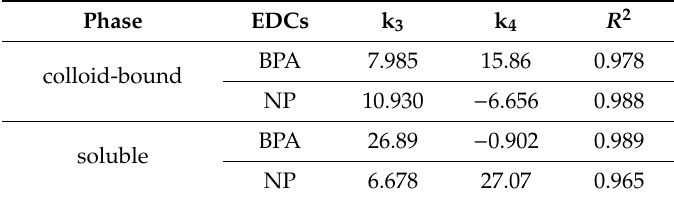
Table 5. Coe ffi cients of nonlinear fitting of DOM and EDCs content in two phases. Table 5. Coefficients of nonlinear fitting of DOM and EDCs content in two phases. Phase Phase EDCs k 3